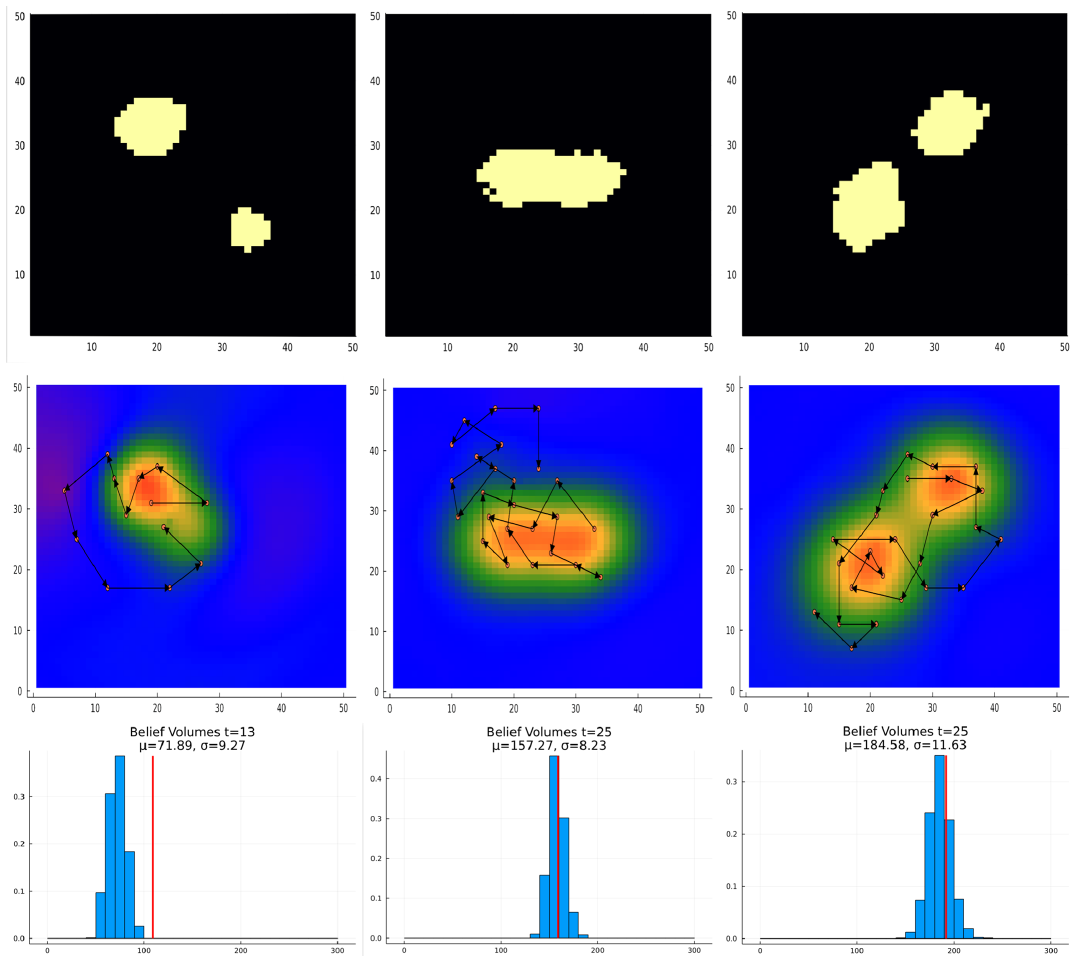
Figure 31. Deposit size study results for multi-body case. The sub-economic, borderline, and economic cases are shown in the left, center, and right columns, respectively. The top row shows the massive ore present in the tested case. The center row shows the trajectory taken by POMCPOW and the standard deviation of the resultant belief. The bottom row shows the histogram of the ore volumes in the final belief along with the true massive ore